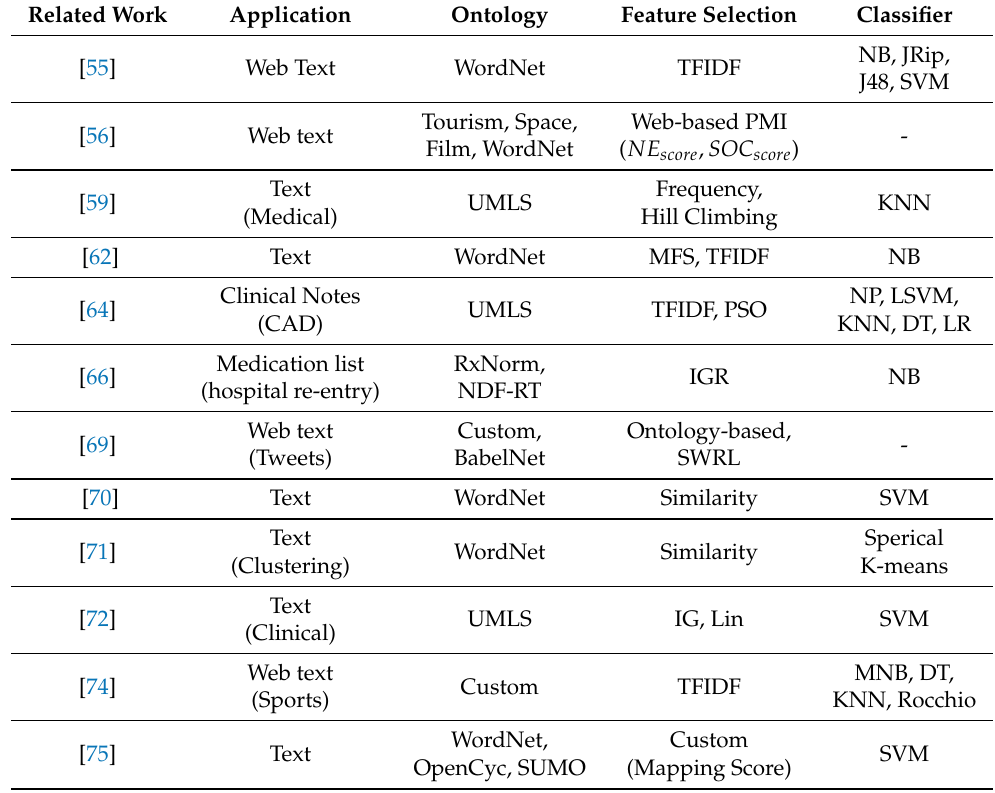
Table 1. Document classification organized according to specific